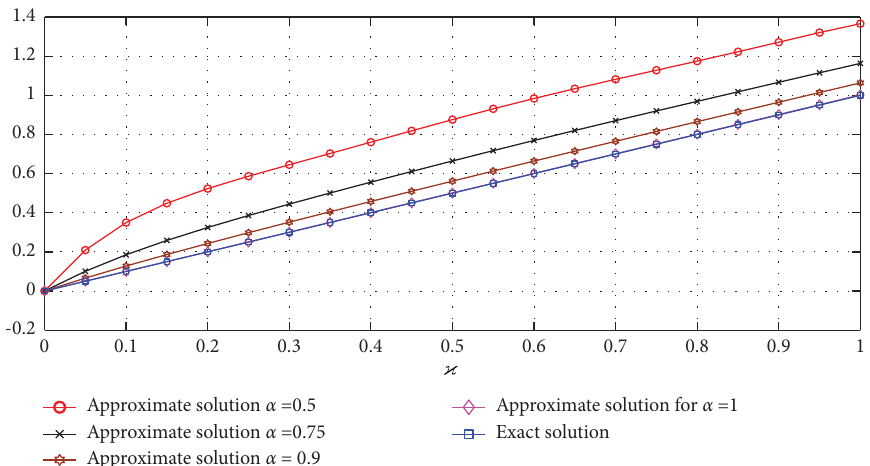
Figure 6: Exact and approximate solutions for diferent α obtained for m � 6 for Example